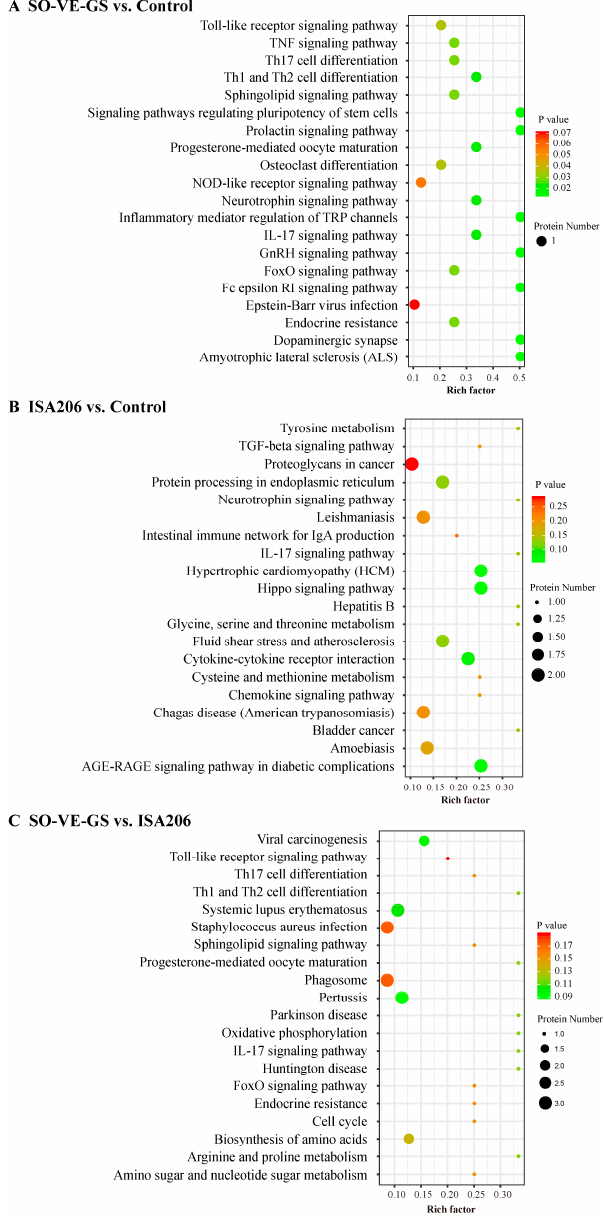
Figure 6. Enrichment of Kyoto Encyclopedia of Genes and Genomes (KEGG) pathways analysis. DEPs of ( A ) SO-VE-GS vs. control, ( B ) ISA 206 vs. control, and ( C ) SO-VE-GS vs. ISA 206 were used for KEGG pathway analysis. The x-axis represents the value of the rich factor. The y-axis represents the enrichment term of the pathways. The size of the dot represents the number of DEPs. The color represents corrected P value.